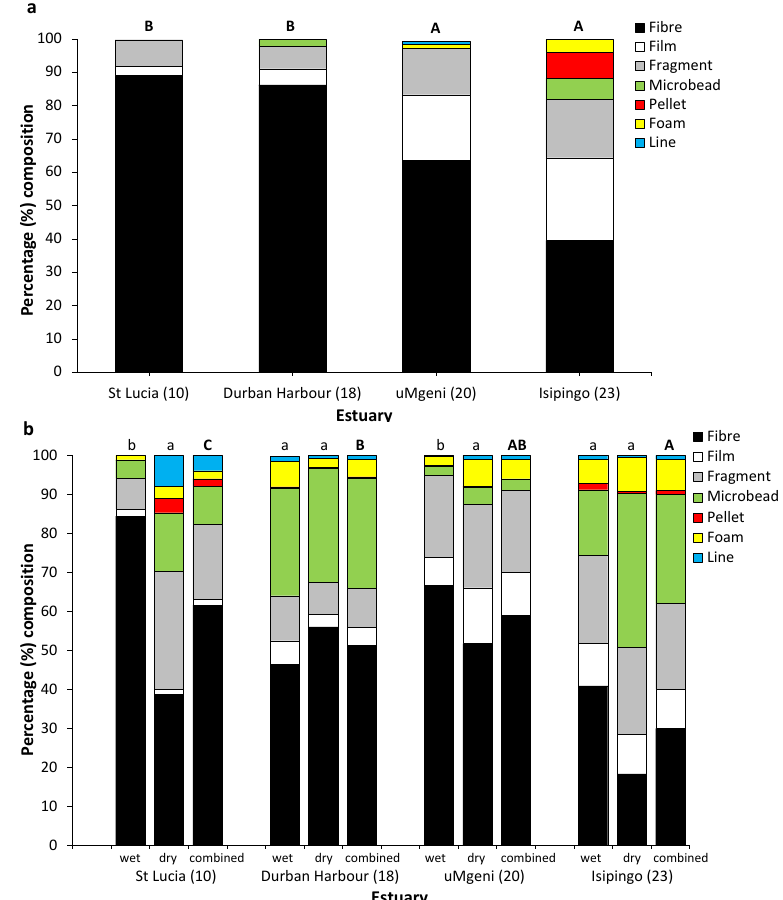
Figure 6. Proportional distribution of microplastic for ( a ) surface water (n = 12 per estuary, seasonal data pooled due to no significant differences between seasons) and ( b ) mangrove sediment (n = 9 per season, per estuary) at the four estuaries sampled. Uppercase letters indicate significant differences in the proportional distribution of microplastic (MP) types across estuaries based on combined seasonal data ( p < 0.0001 in both ( a ) and ( b ); ANOVA). Lowercase letters indicate significant differences in the proportional distribution of MP types between seasons within each estuary ( p = 0.02 in ( b ); ANOVA). The total disturbance score (TDS) is given within brackets for each estuary on the x- axis.